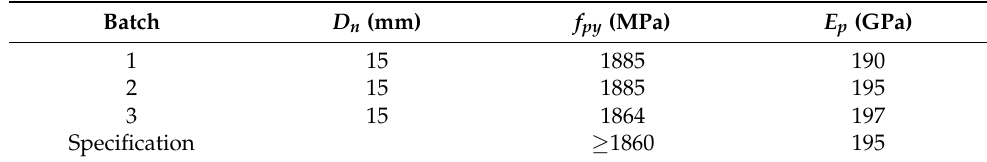
Table 3. Mechanical properties of prestressed